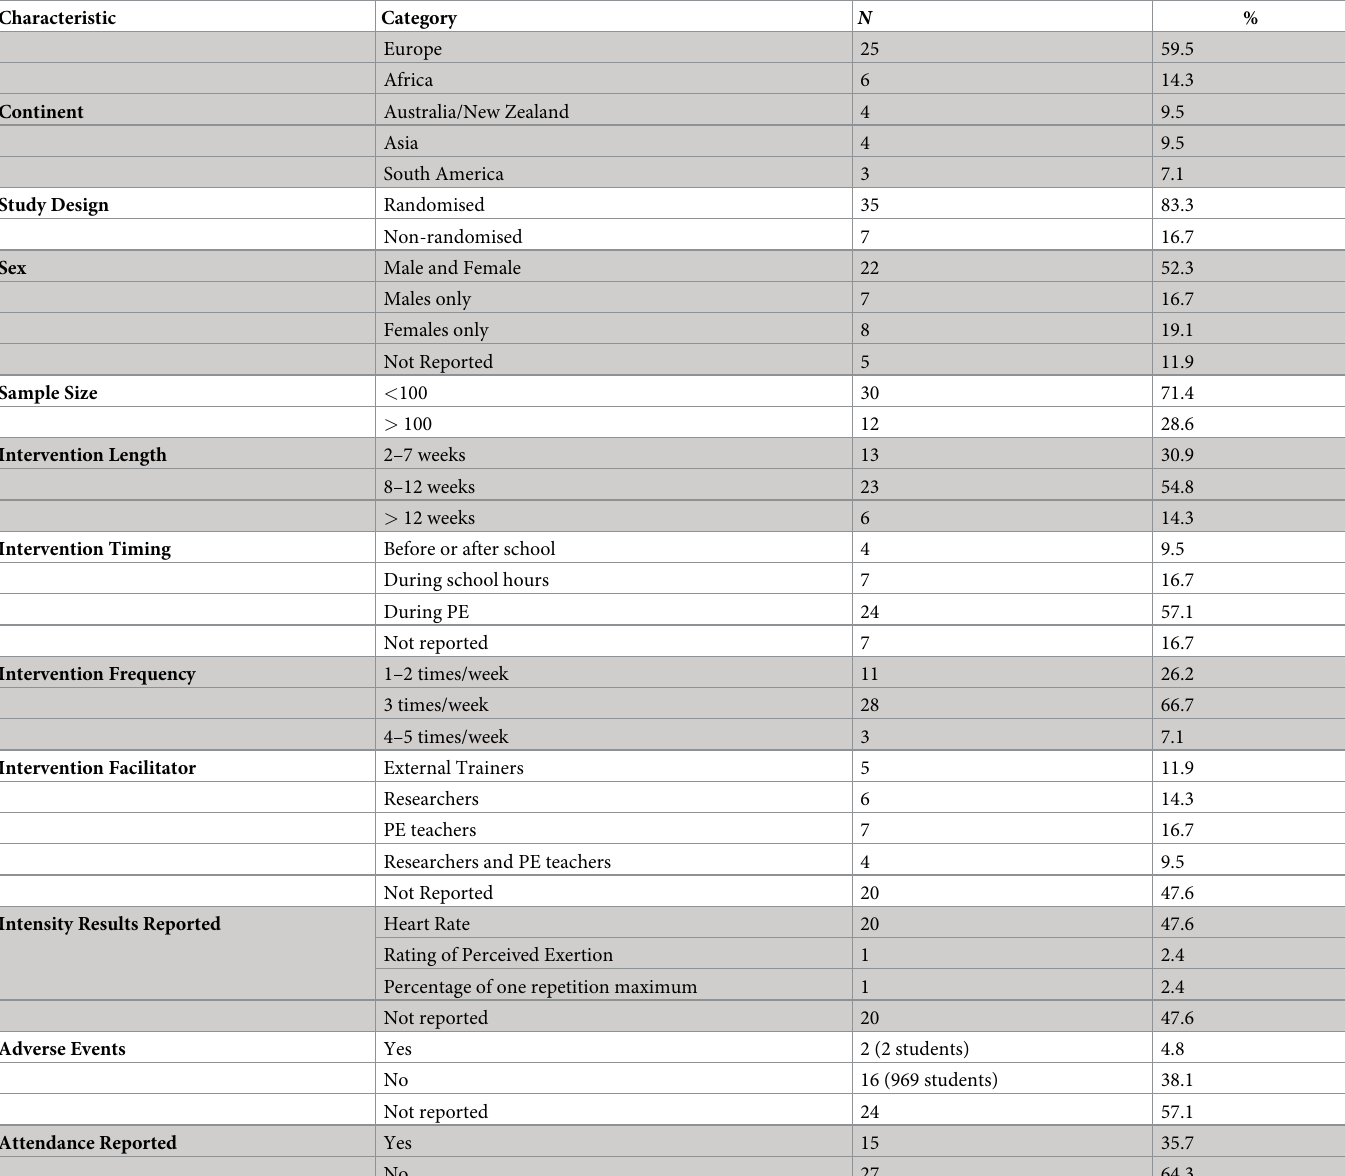
Table 1. Summary of study and program